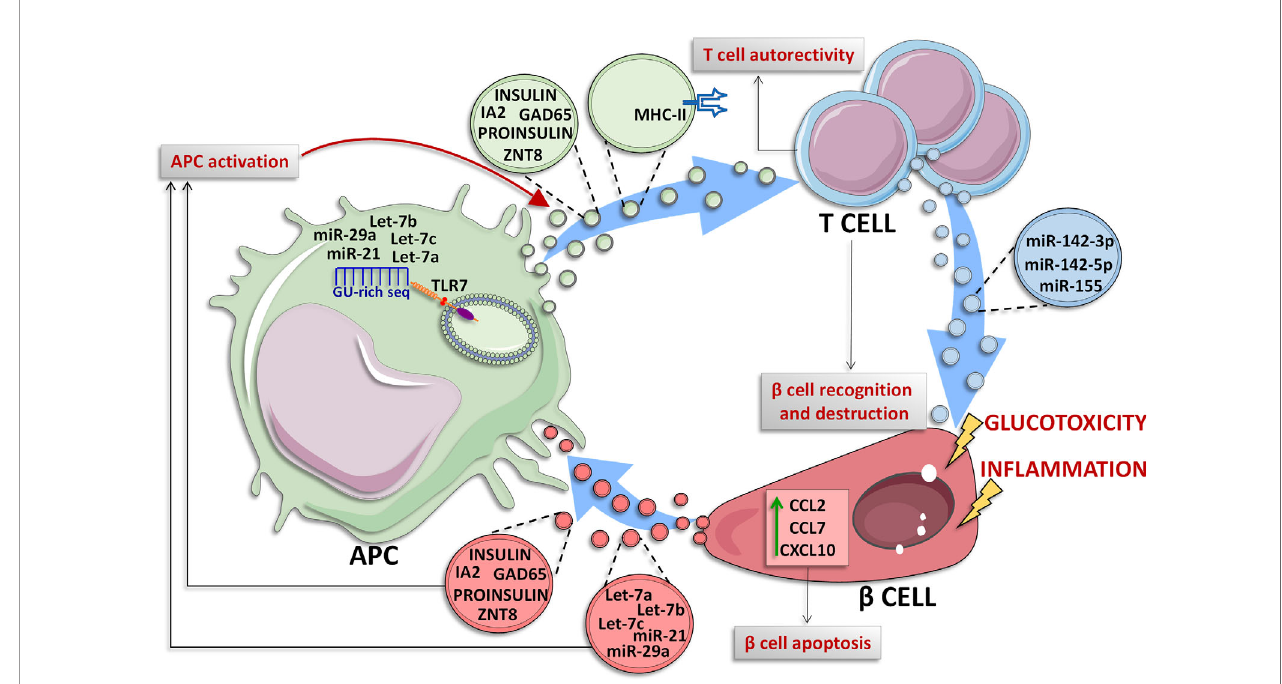
FIGURE 2 | Crosstalk between b cells and immune cells through EVs. In T1D context, b cells and immune cells tightly communicate each other. b cells are subjected to glucotoxic and/or in fl ammatory stress and can release EVs containing speci fi c miRNAs characterized by a GU-rich sequence (let-7a/b/c, miR-21 and miR-29a) which are transferred to resident Antigen Presenting Cells (APCs), where these miRNAs can bind to endosomal Toll Like Receptor 7 (TLR7) leading to the activation of in fl ammatory signals (140 – 142). Moreover, under in fl ammatory stress, b cells secrete and transfer EVs to APCs. Such EVs can contain speci fi c autoantigens such as insulin, IA2, ZNT8, GAD65 and proinsulin (5) thus leading to their transfer to APC which can present these antigens for adaptive immunity activation. Activated APC can also lead to CD4 + T cells activation through two different mechanisms: ( i ) release of EVs containing insulin, IA2, ZNT8, GAD65 and proinsulin autoantigens (4), or ( ii ) release of EVs exposing MHC-II on their surface through which APCs present autoantigens to CD4 + T cells (86, 87), leading to autoreactive T cell activation and subsequent b cell destruction. In T1D context, pancreatic islet-in fi ltrating T cells secrete a speci fi c subpopulation of EVs carrying miR-142-3p/5p and miR-155 which can be transferred to b cells; these miRNAs cause the upregulation of in fl ammatory molecules such as CCL2, CCL7 and CXCL10 leading to b cell apoptosis